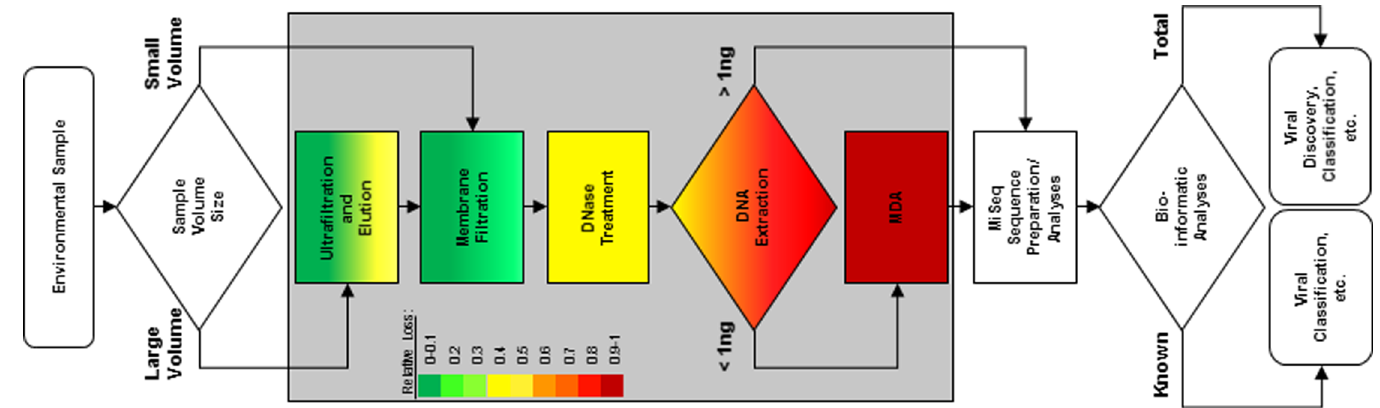
Fig 8. Sample to sequence work flow diagram illustrating the relative losses identified at each of the steps involved for wastewater viral metagenomic analysis. Relative losses were quantified in specific steps inside the shaded area. A heat map was generated to graphically represent the losses measured at the ultrafiltration and elution, membrane filtration, DNase treatment, DNA extraction and MDA steps. Heat map legend is shown on the left side of the shaded box.